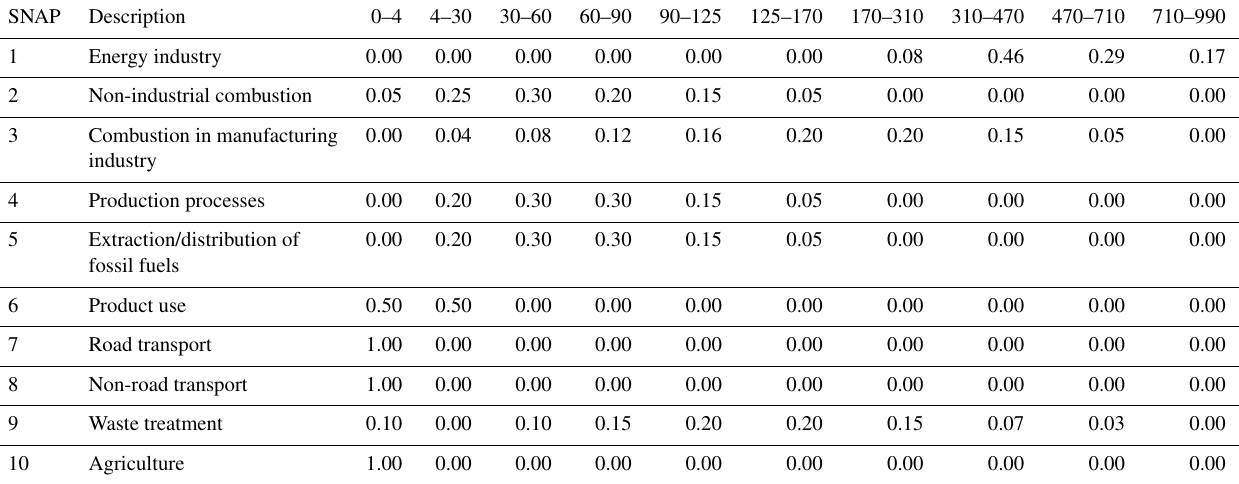
Table 2. Vertical emission profiles for point sources for different SNAP categories as fractions of the total emitted mass per vertical layer. Layers are denoted by their lower and upper limits (meters above ground).